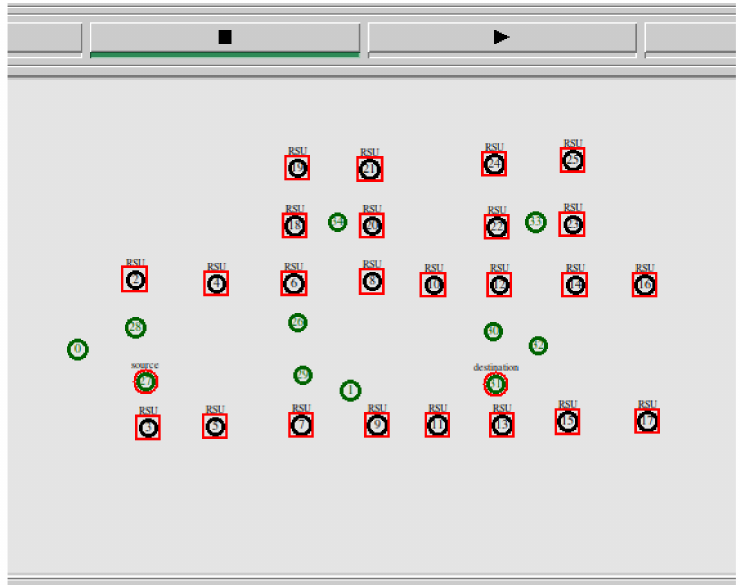
Figure 2. Source node and destination